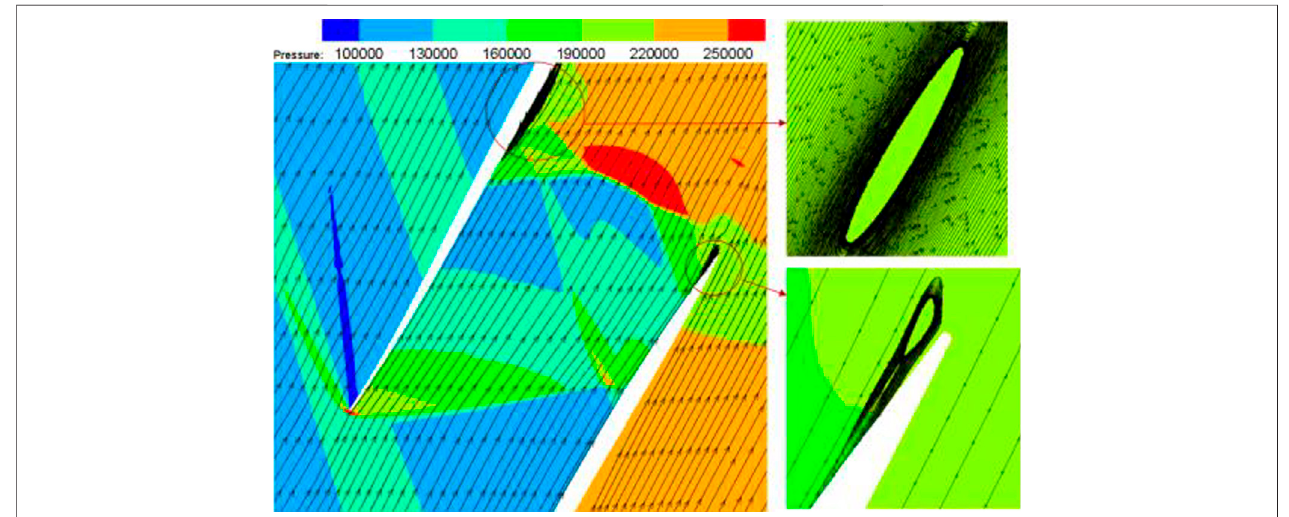
FIGURE 6 | Pressure contours of the